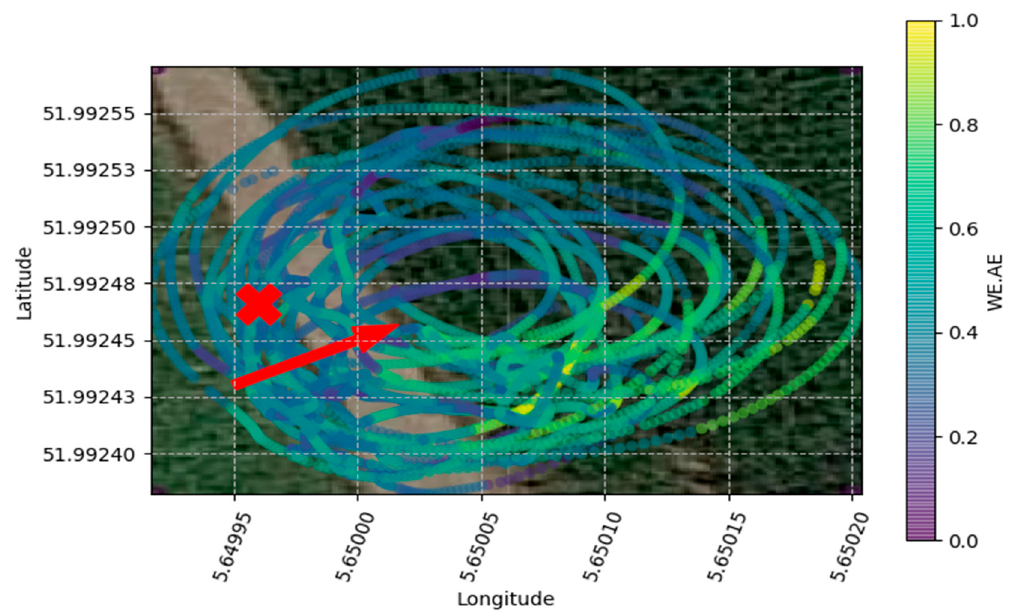
Figure 4. Variation of NO 2 during the spiral flight trial executed during the high wind day. Background satellite image was acquired from Google database. The red X indicates the position of the NO 2 source and the red arrow indicates wind direction.